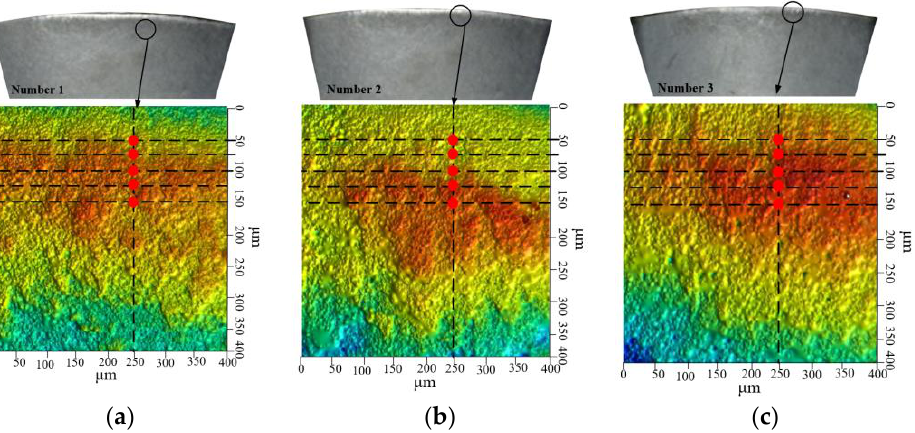
Figure 13. Experimental results of the wear profile of three blades of scheme 1: ( a ) tooth 1; ( b ) tooth 2; ( c ) tooth 3.